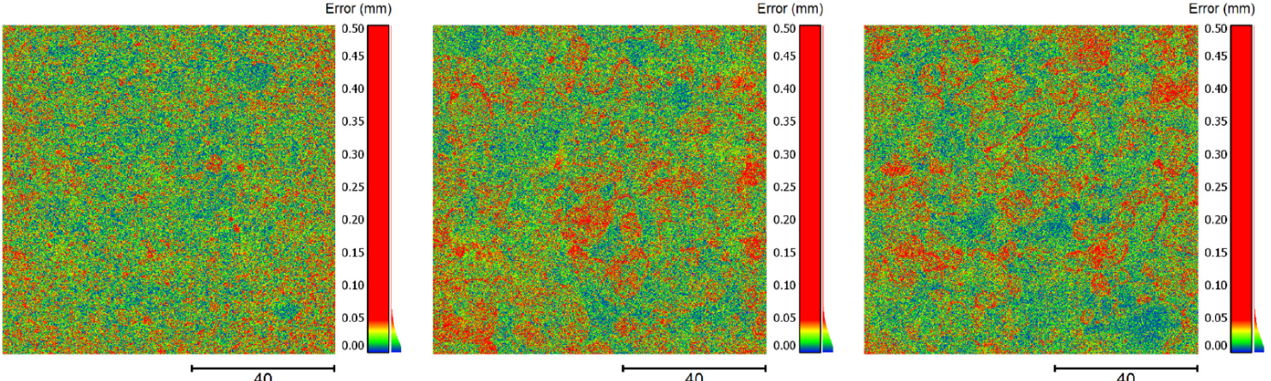
Figure 11. False color maps depicting the point distances of pairs of point clouds from same specimens—to the left specimen 1, in the center specimen 2 and to the right specimen 3.